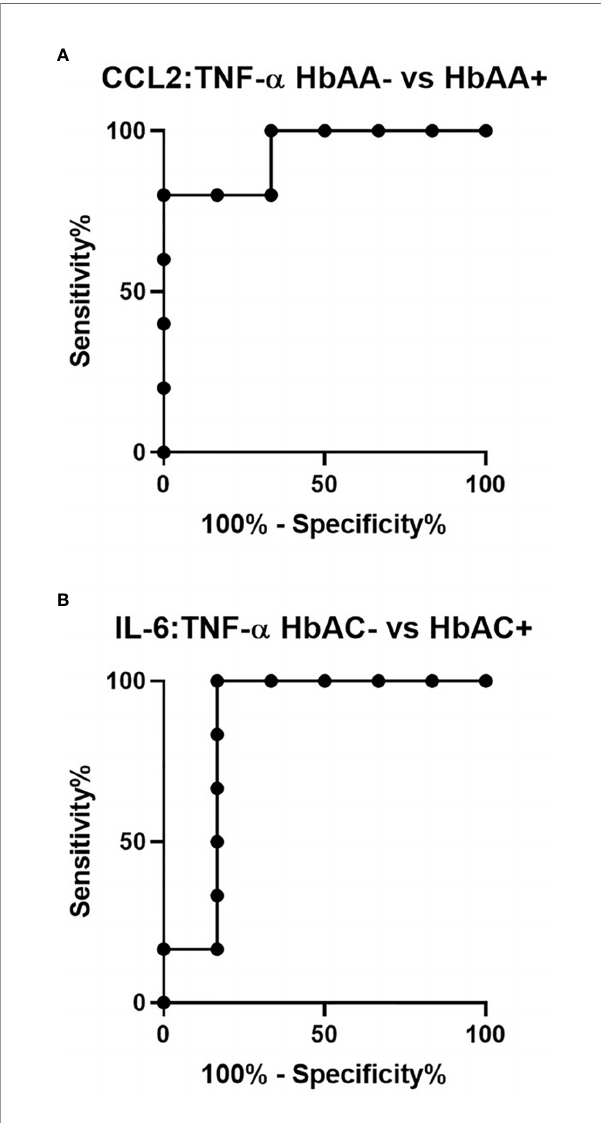
FIGURE 5 | ROC analysis for CCL2:TNF- a and IL-6:TNF- a . (A) CCL2:TNF- a independently discriminate between HbAA- vs HbAA+ with an AUC = 0.93 and P = 0.02. (B) IL-6:TNF- a independently discriminate between HbAC- vs HbAC+ with an AUC = 0.86 and P =